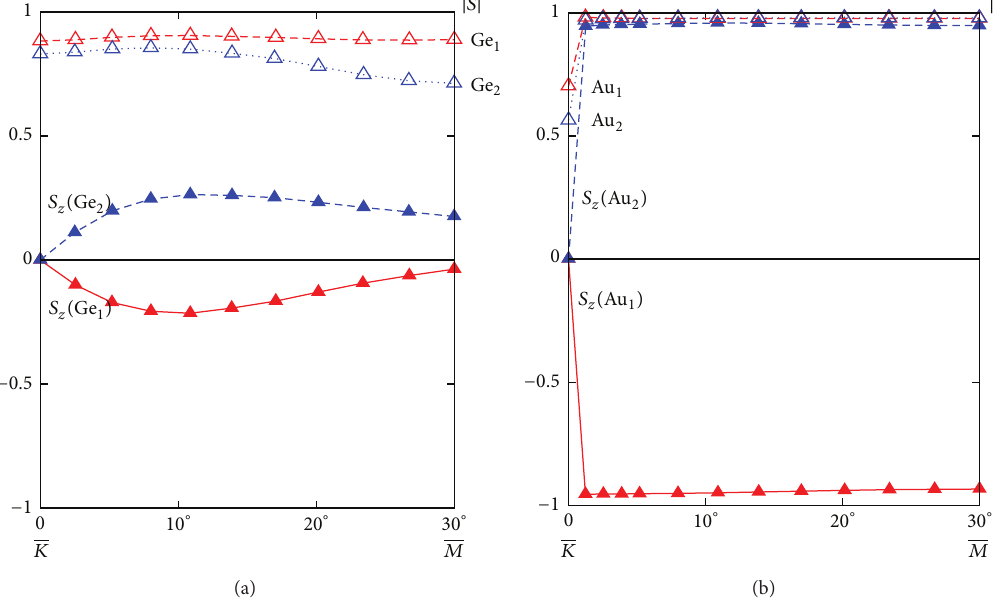
⃗𝑆| = √𝑆 2 + 𝑆 2 + 𝑆 2 𝑥 𝑦 𝑧 (empty triangles). The values of spins given in